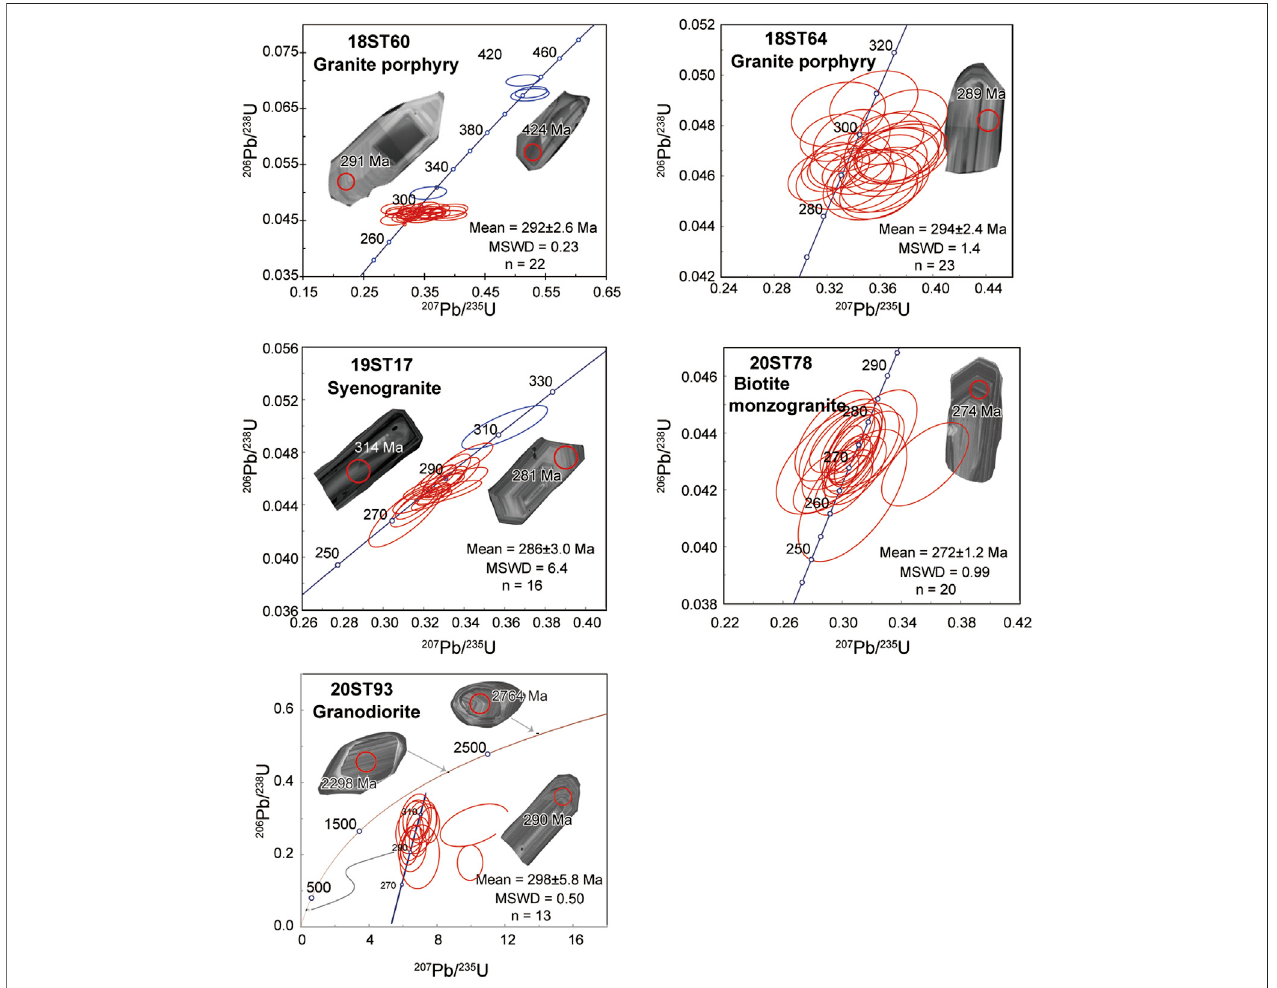
FIGURE 4 | U-Pb Concordia diagrams and representative cathodoluminescence (CL) images of zircons from the Permian granitoids in this study. Ages are in Ma and ellipses show 1 σ errors. Red circles indicate positions of dated laser spots. Ellipses in blue represent ages of inherited zircons, and consequently were excluded in the calculations of weighted mean